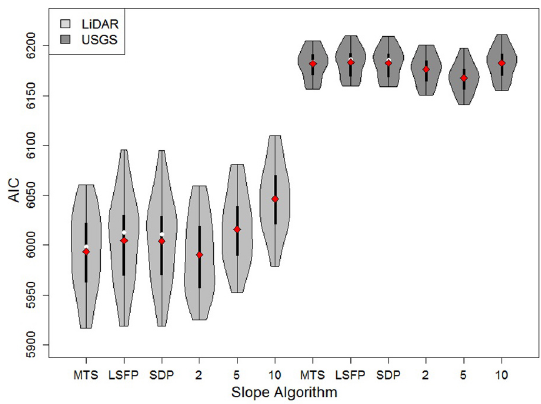
Figure 5. AIC values vs. flow direction algorithm for the lidar (light grey; 3 and 10m) and USGS (dark grey) data sets. Mean and median values are depicted as red diamonds and white dots,